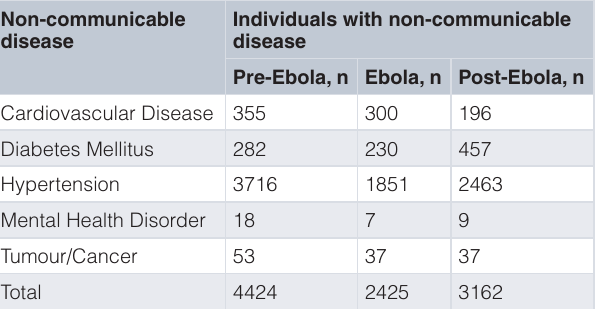
Table 1. Numbers of people with non-communicable diseases in the Pre-Ebola, Ebola and Post-Ebola periods in the Western Area District, Sierra Leone: 2013 – 2015. Pre-Ebola: June to December 2013; Ebola: June to December 2014; Post-Ebola: June to December